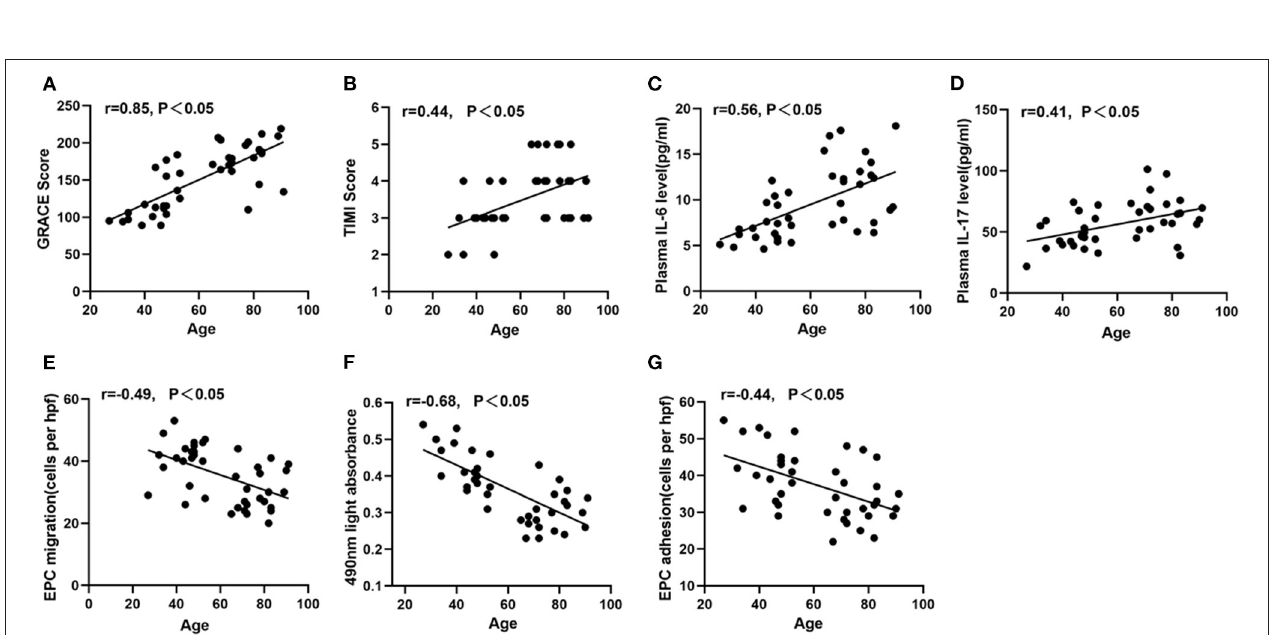
FIGURE 6 | Correlation between age and GRACE or TIMI score or inflammatory cytokines or circulating EPC function. Age was positively correlated with GRACE score (A) , TIMI score (B) , IL-6 (C) , IL-17 (D) . Age was negatively correlated with EPC migration (E) , proliferation (F) , and adhesion (G) .